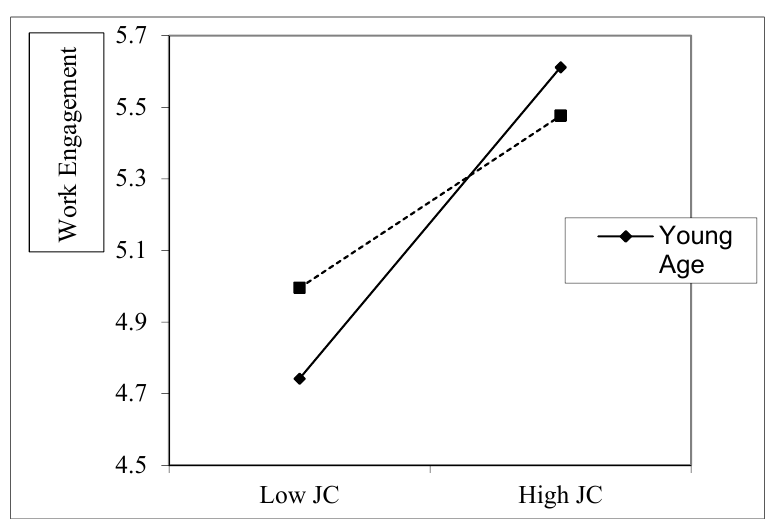
Figure 2. Moderation role of age on the mediation effect of work engagement on the JC (Job Crafting) –occupational satisfaction relationship.